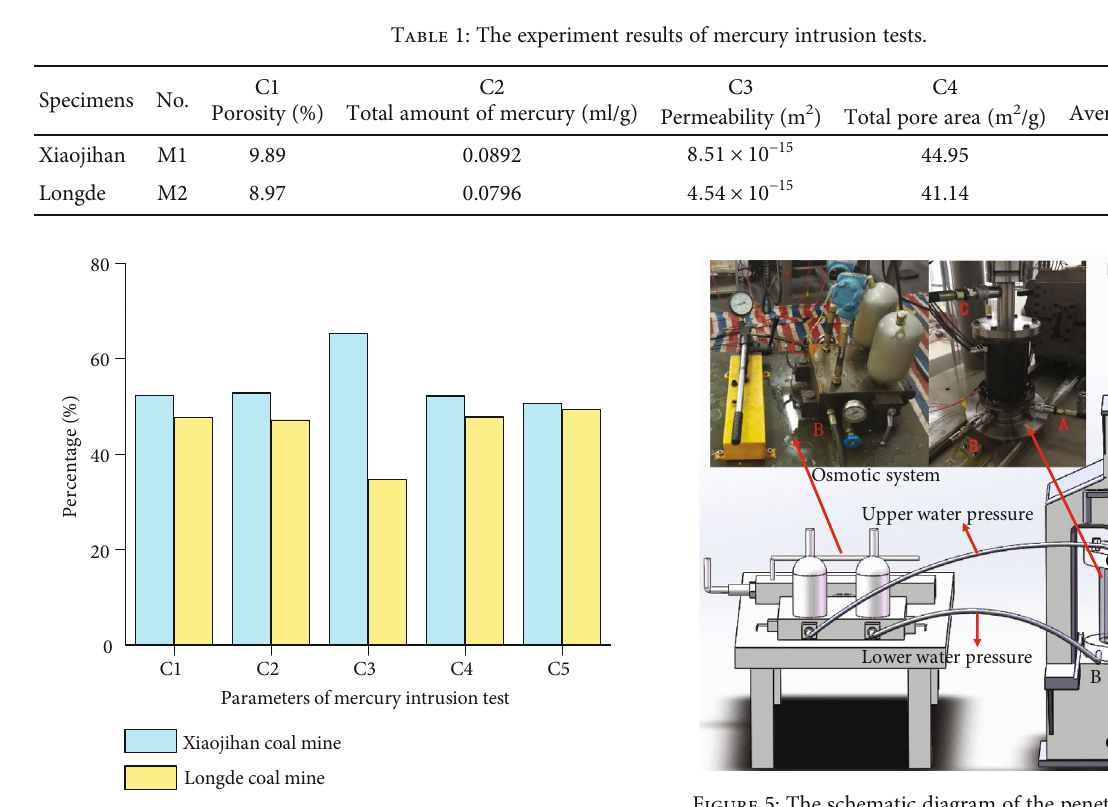
Figure 4: The experiment results of mercury intrusion tests of the water-bearing coal seam and no-water coal seam. Note: (a) C1, C2, C3, C4, and C5 denote porosity, total amount of mercury, permeability, total pore area, and average pore size, respectively. (b) The ordinate indicates the proportion of the two coal seams under the same parameter.